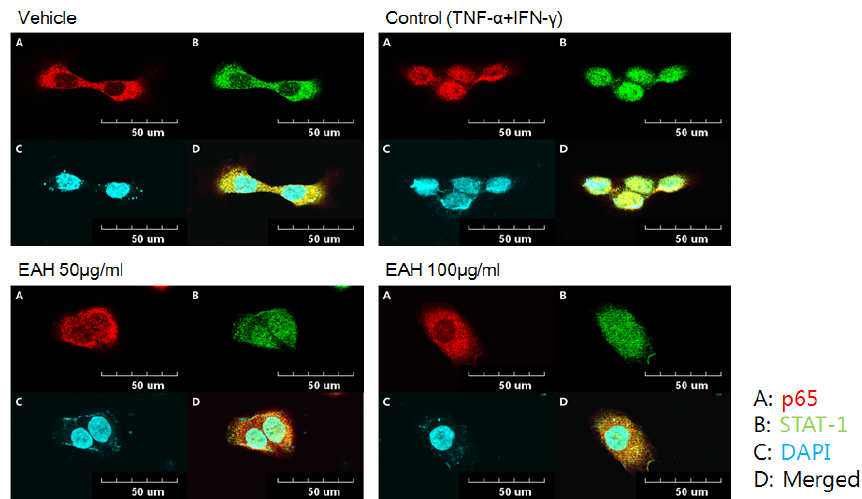
Figure 4. Effects of EAH on translocation of STAT-1 and NF-κB in TNF-α/IFN-γ–stimulated HaCaT cells. Confocal microscopy analysis of NF-κB p65 (A) and STAT-1 (B) in HaCaT cells. The cells were pretreated with EAH for 1 h and stimulated with TNF-α/IFN-γ for 20 min. Incubation was stopped